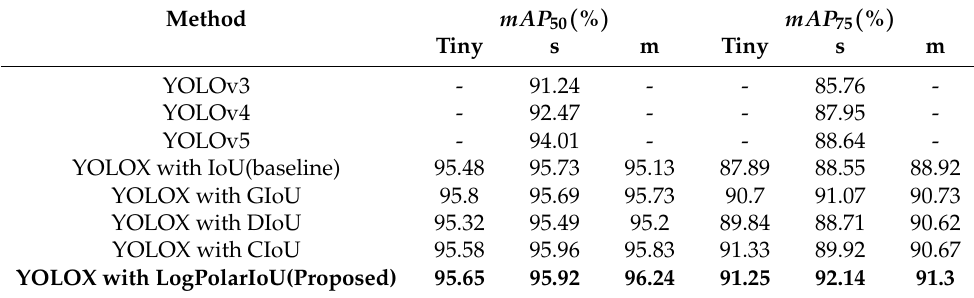
Table 5. Experimental results of different YOLO models with different IoU on YOLOX model.